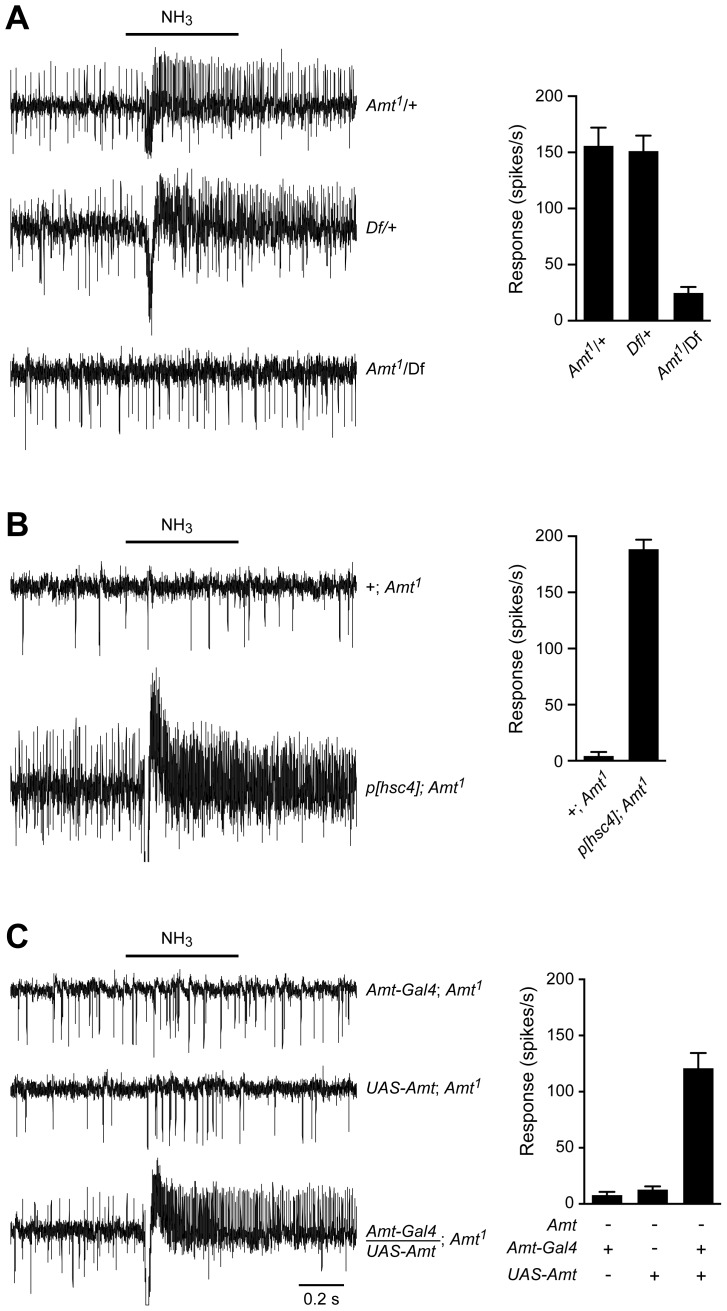
The loss of ammonia response localizes to the Amt gene.(A) Traces on the left show that the responses to a 500 ms pulse of 0.1% ammonia are similar in flies heterozygous for the Amt1 transposon and the Df(3R)BSC471 deficiency that removes ∼30 kb including Amt and nine other genes. In contrast, Amt1/Df(3R)BSC471 flies have greatly reduced responses to ammonia (n = 9 each, p<0.0001). Averaged data are shown in the graph on the right. (B) The lack of response to 0.1% ammonia in ac1 sensilla from Amt1 flies is rescued by the addition of a genomic fragment containing Amt and the neighboring gene Hsc70-4 (n = 8 each, p<0.0001). (C) The response to ammonia in Amt1 mutant flies is also rescued by transgenic expression of UAS-Amt under the control of an Amt-Gal4 promoter (n = 9 each, p<0.0001).